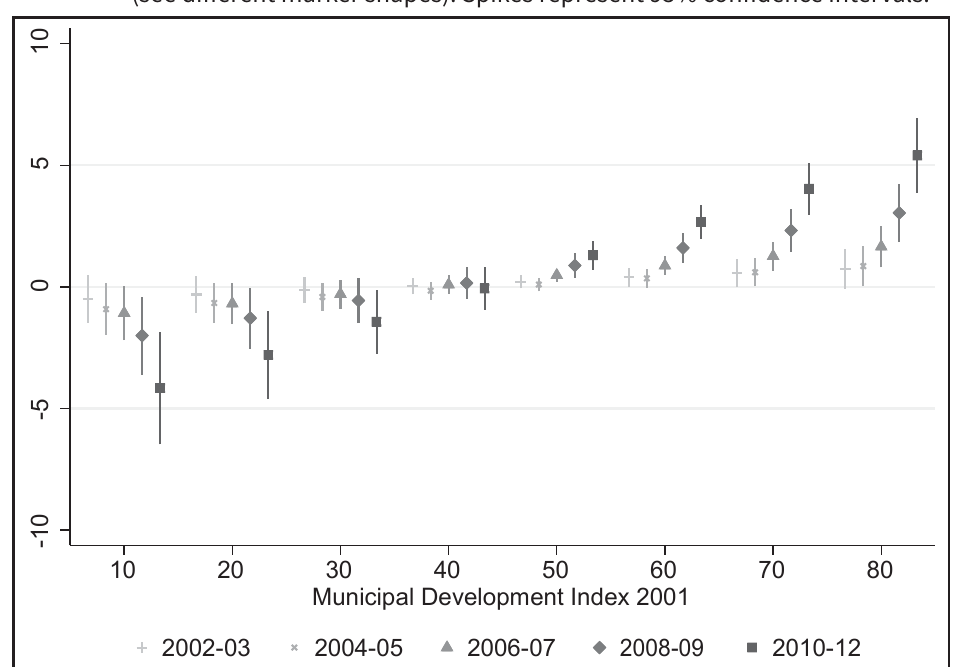
Figure 3 The overall effect of municipal autonomy on test scores, by MDI and time. Notes: The figure plots the marginal effects of municipal autonomy on test scores, by level of municipal development (on x -axis) and at different postreform periods (see different marker shapes). Spikes represent 95% confidence intervals.